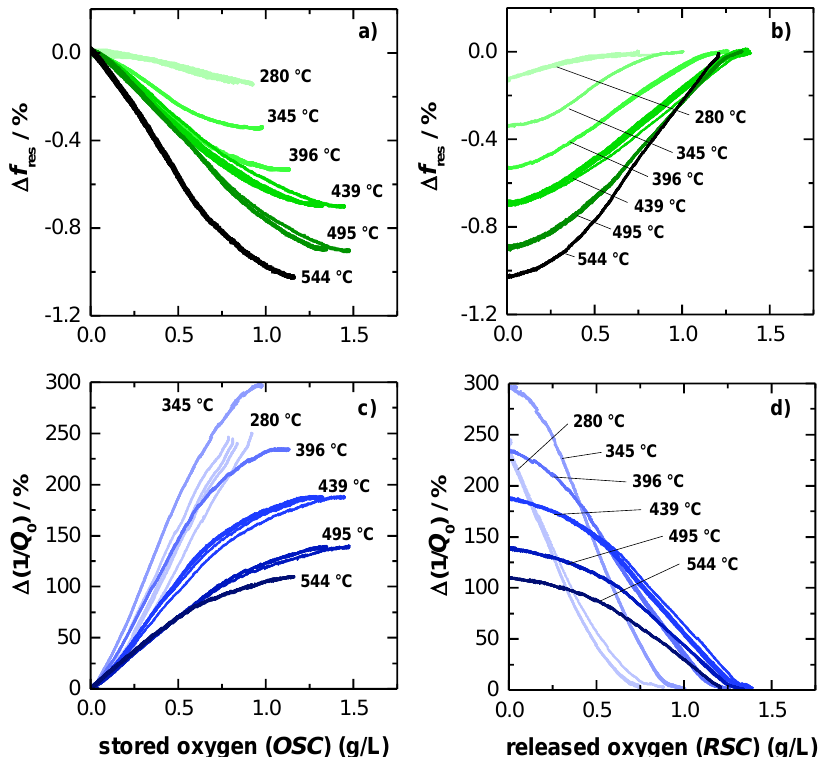
Figure 5. Correlation of the relative resonant frequency amplitude and the oxygen storage level during ( a ) rich-lean switch and ( b ) lean-rich switch. Correlation of the relative amplitude of the unloaded quality factor and the oxygen storage level during ( c ) rich-lean switch and ( d ) lean-rich switch.